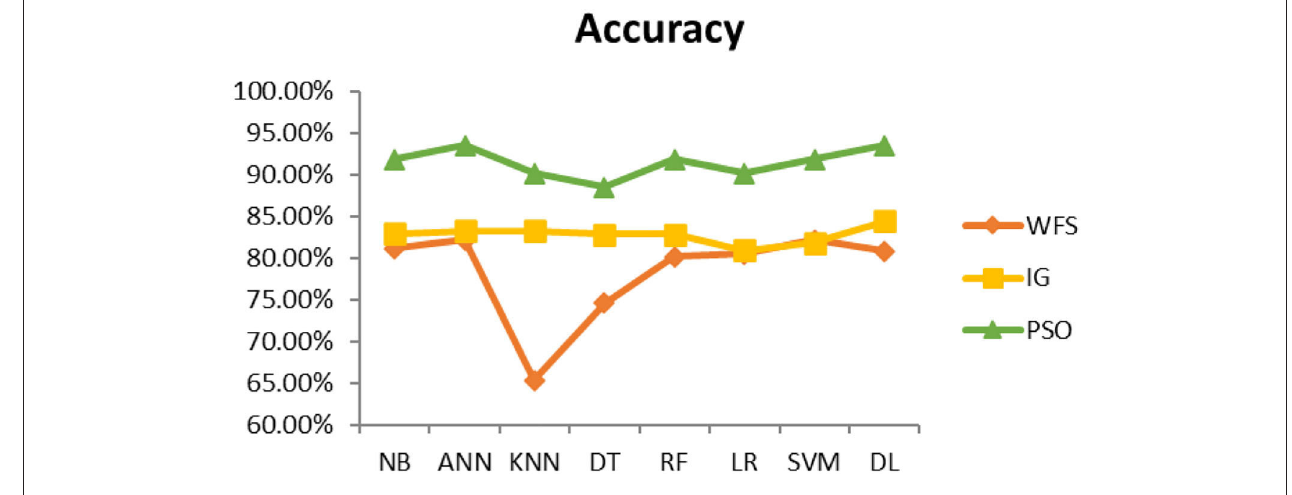
FIGURE 7 | Heart attack diagnosis accuracy (dataset 1).